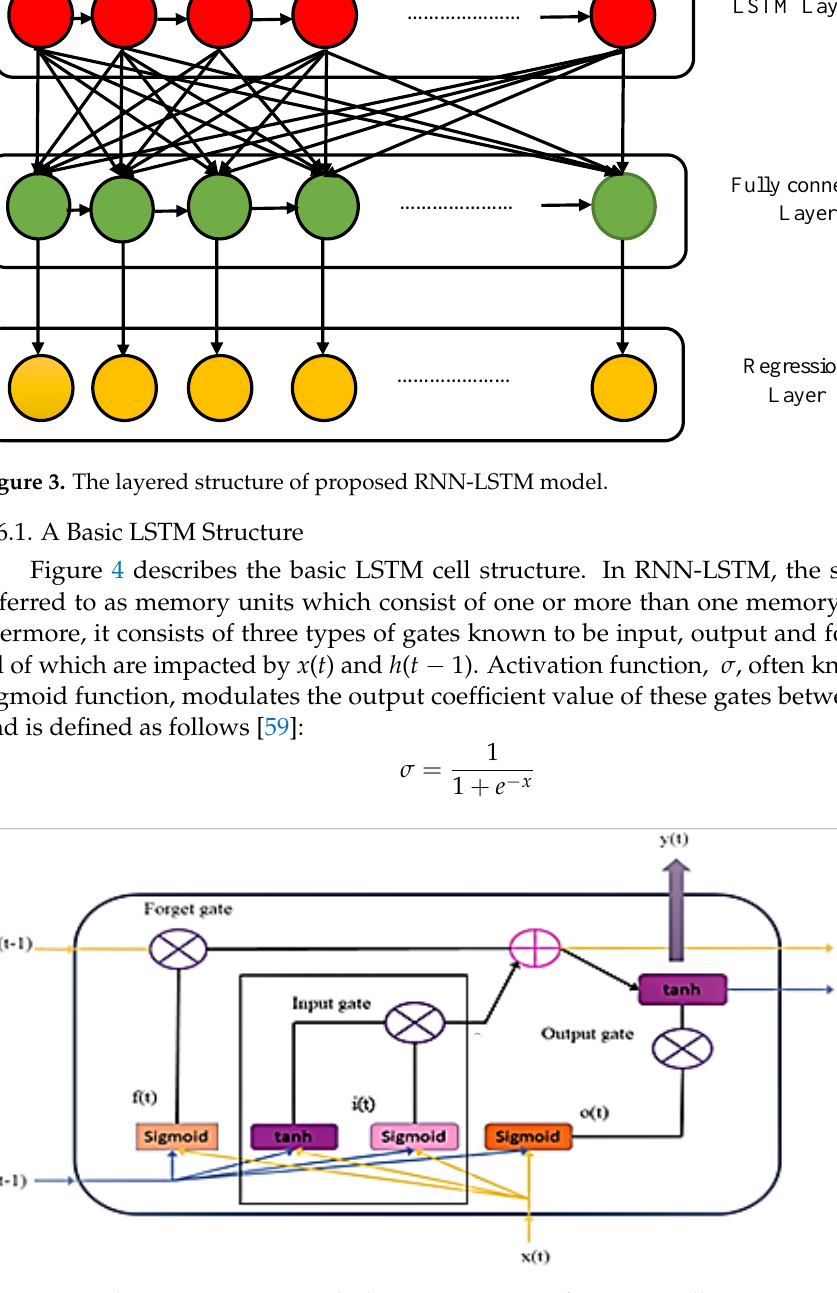
Figure 4. A schematic representing the basic construction of an LSTM